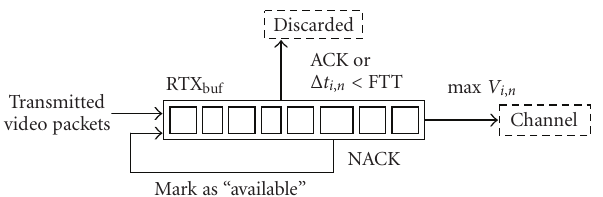
Figure 2: Diagram of the scheduling algorithm for packet retrans-